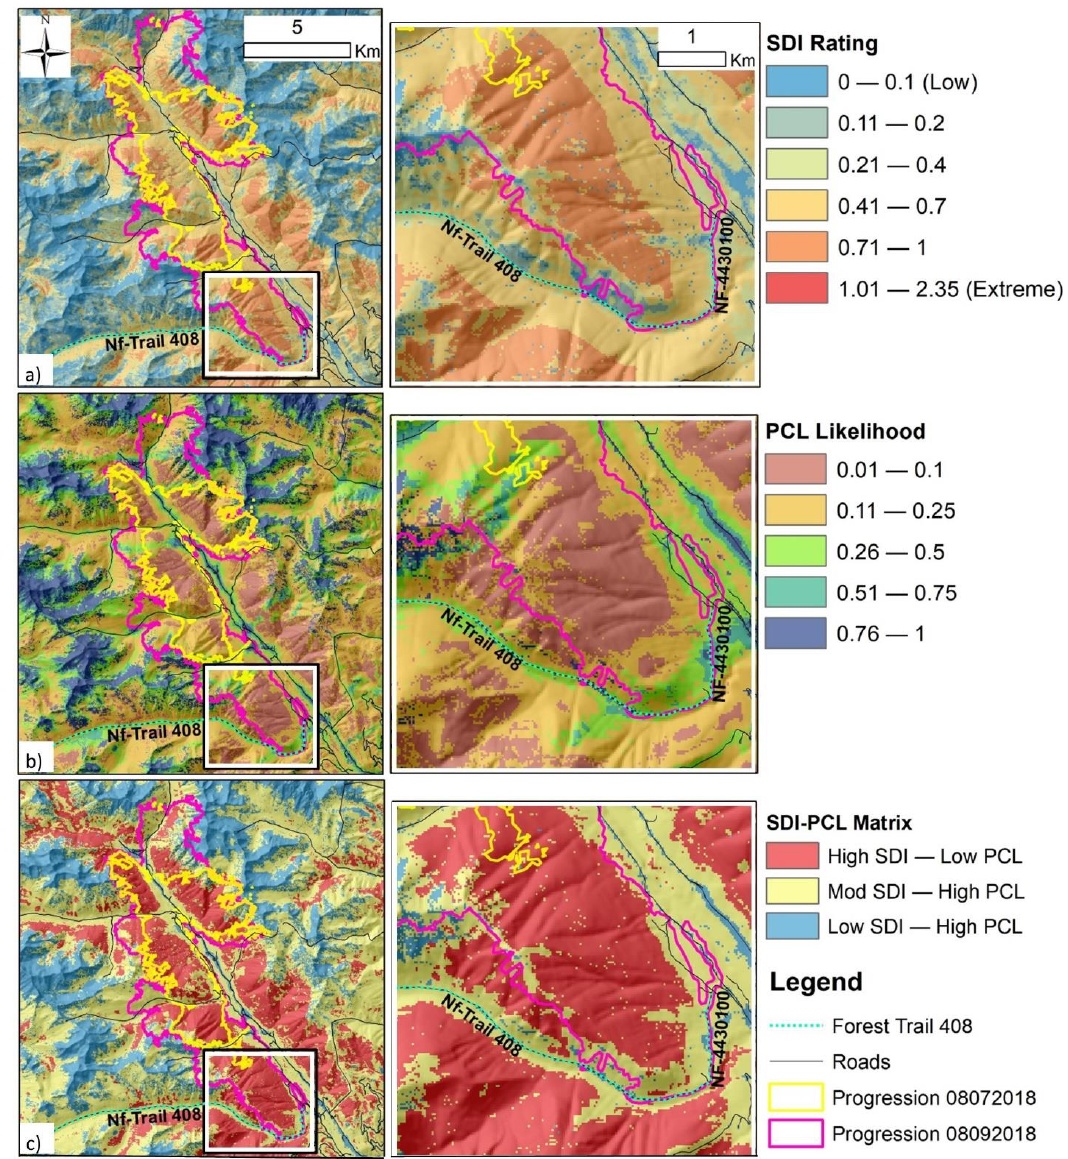
Figure 4. Fire analytics maps supplied to an out-of-area IMT regarding the 2018 Crescent Mountain Fire on the Okanagan- Wenatchee National Forest of Washington State. Maps of the suppression difficulty index ( a ) and potential control locations ( b ) were used together ( c ) to develop containment strategies and to communicate these strategies with Agency Administrators and the public.